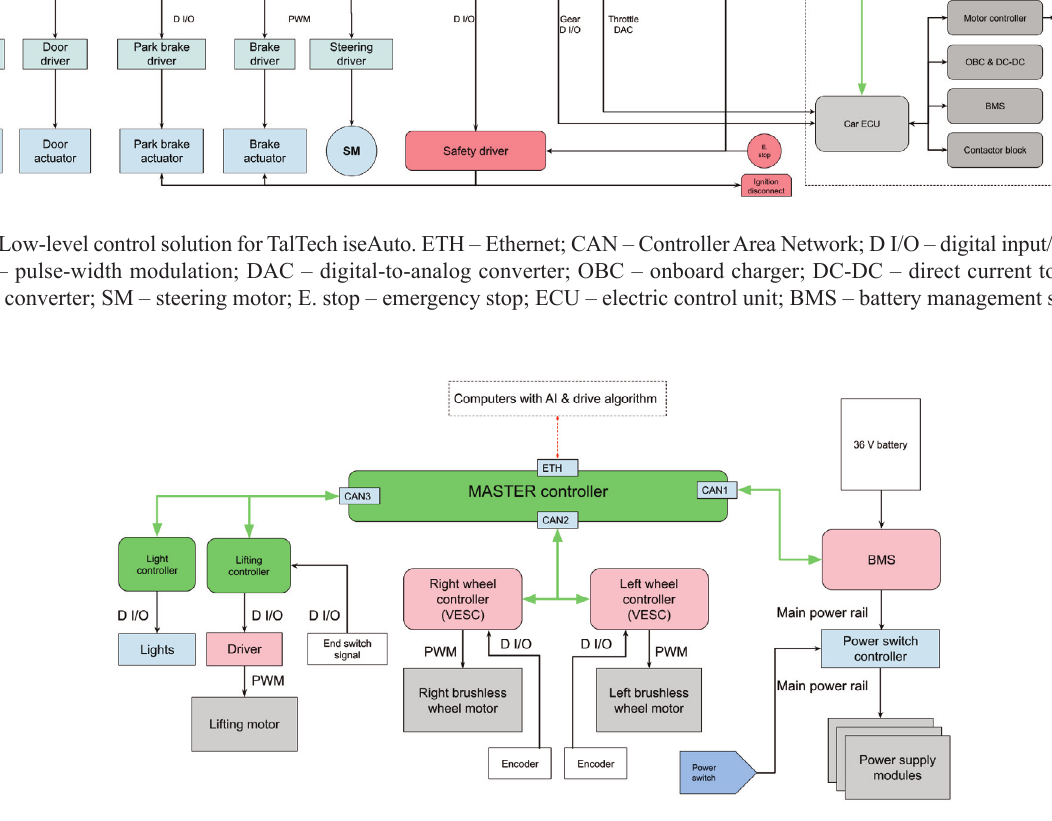
Fig. 2. Low-level control solution for TalTech